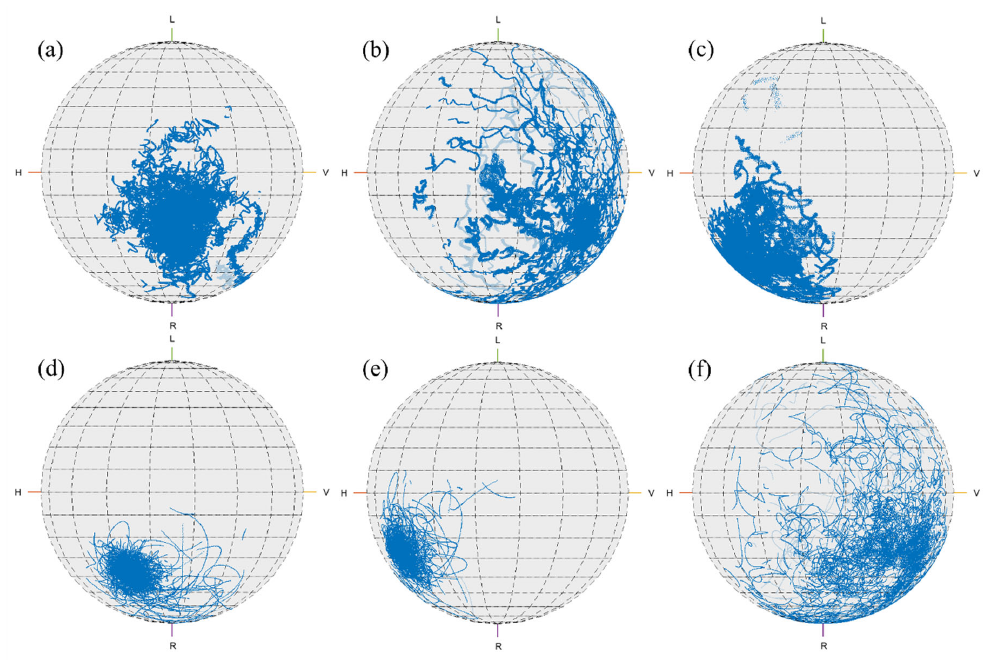
Figure 16. Hungary beacon: Poincaré sphere representation of measured polarization state for representative samples from each of six days: ( a ) 26 June; ( b ) 23 July; ( c ) 29 July; ( d ) 1 August; ( e ) 18 August; ( f ) 20 August 2018. Sample rate ( a – c ): 24,000 samples s − 1 ; ( d – f ): 6000 samples s − 1 .